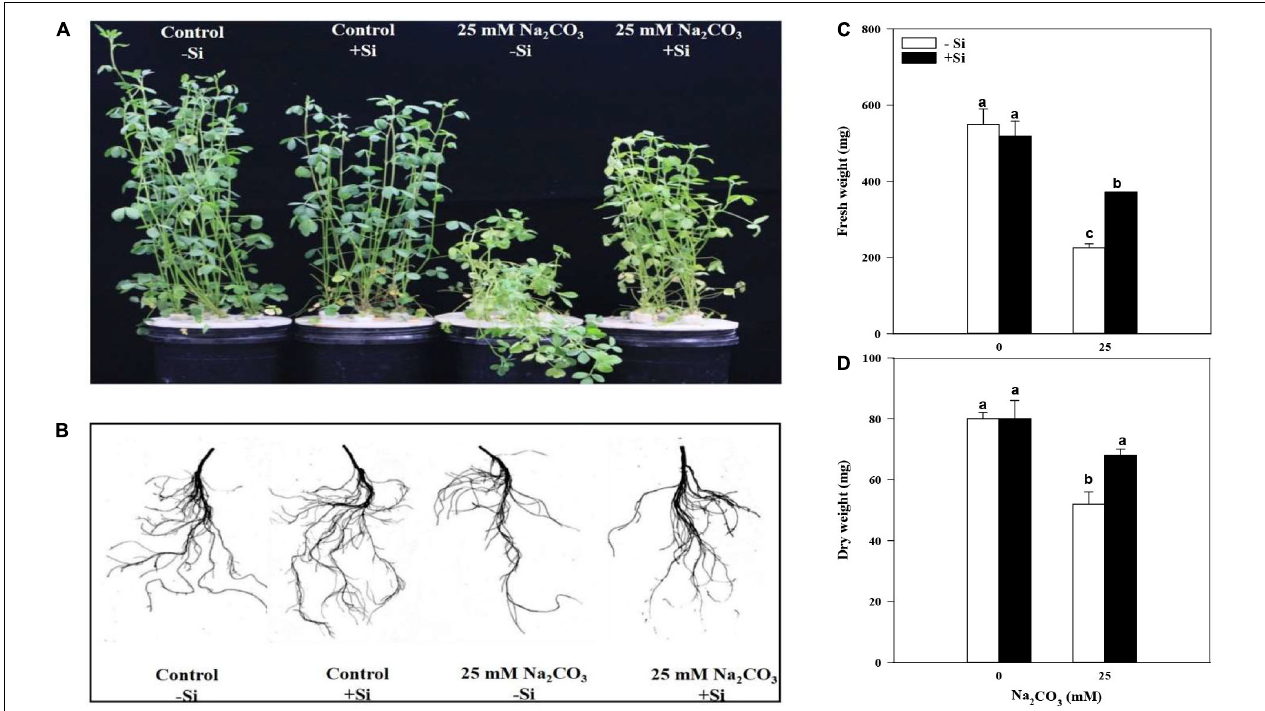
FIGURE 1 | Image of Phenotype (A) , root morphological structures (B) , aboveground fresh weight (C) , and aboveground dry weight (D) of alfalfa seedlings under alkaline stress. − Si = pretreatment without Si; +Si = pretreatment with Si. Values are means ± SE, n = 25. Different letters denote significant difference ( P < 0.05) based on Duncan’s